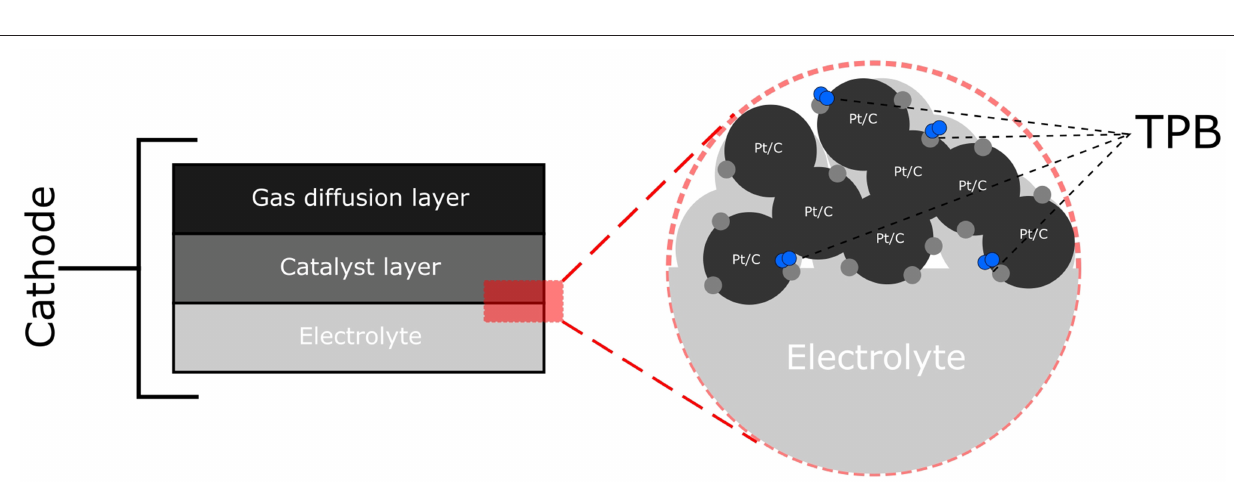
FIGURE 2 | Schematic diagram of the cathode of a PEMFC showing the gas diffusion layer through which oxidant flows and the catalyst layer in contact with the electrolyte where the oxygen reduction reaction (ORR) occurs. This is shown in further detail where the electrolyte is contact with the catalyst (Pt/C). The ORR occurs at the triple phase boundary (TPB) where the electrolyte, the catalyst (Pt/C) and O 2